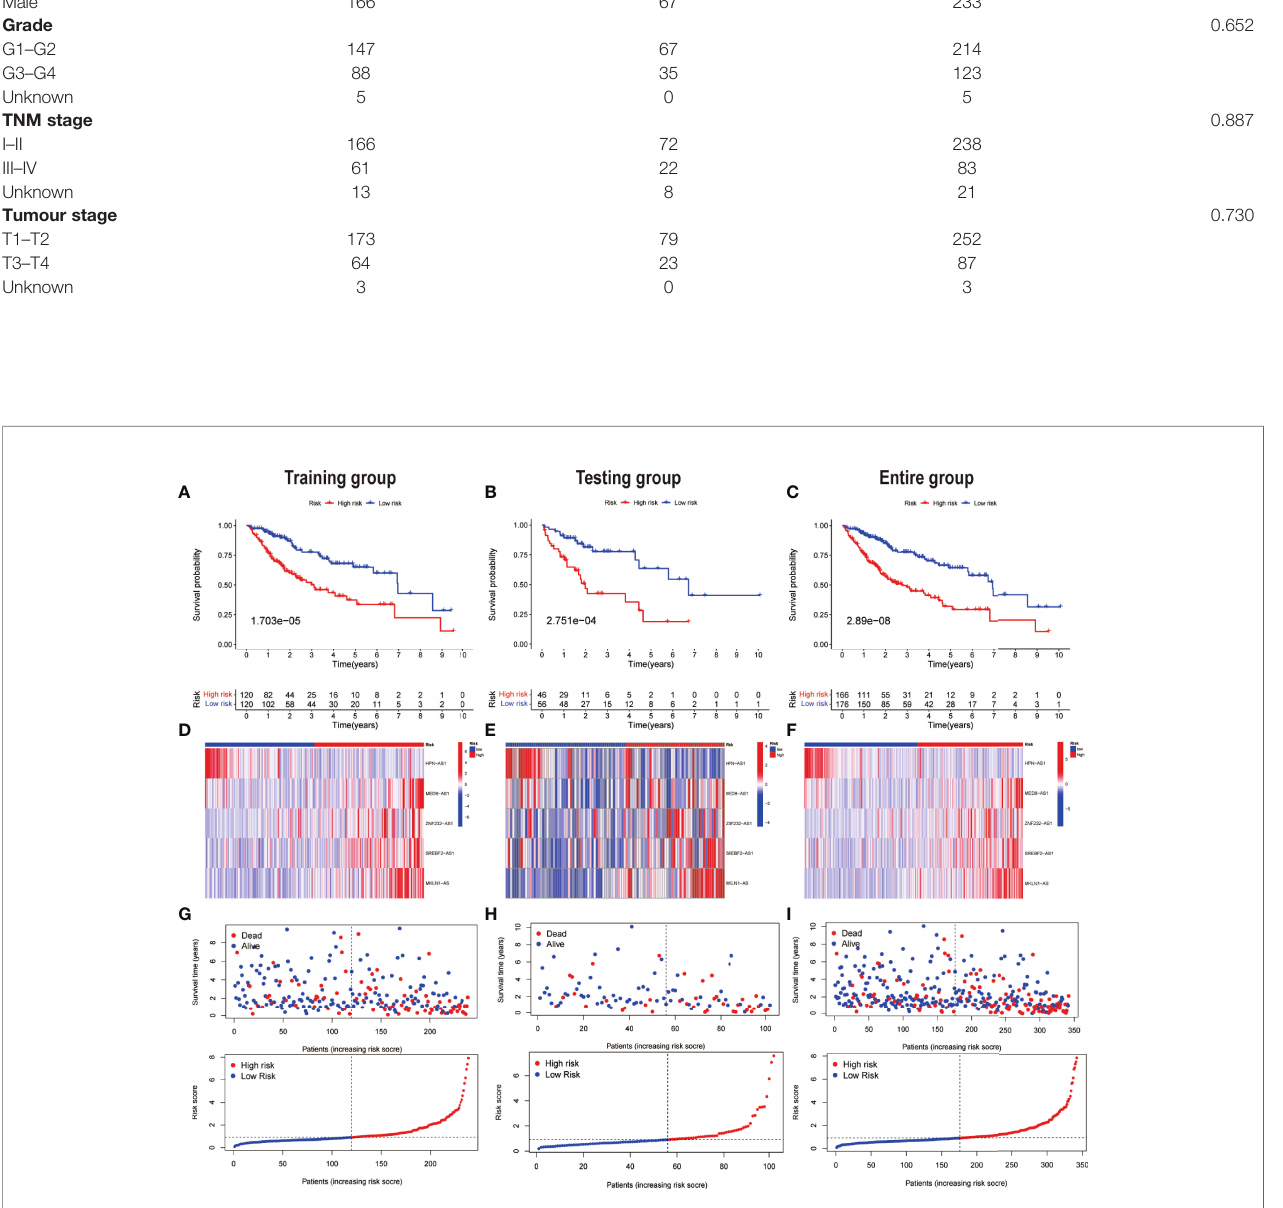
FIGURE 4 | Prognostic value of the risk model of the fi ve PR-lncRNAs. The assessment of overall survival rate among low-risk and high-risk groups of HCC by employing Kaplan – Meier survival curves for the (A) training, (B) testing, and (C) entire set. The presentation of the level of expression of fi ve prognostic lncRNAs via clustering analysis heatmap of each patient enrolled in (D) training, (E) testing, and (F) entire set. The coherence of survival time and survival status among the low- risk and high-risk groups and the distribution of PR-lncRNA model-based risk score for the (G) training, (H) testing, and (I) entire